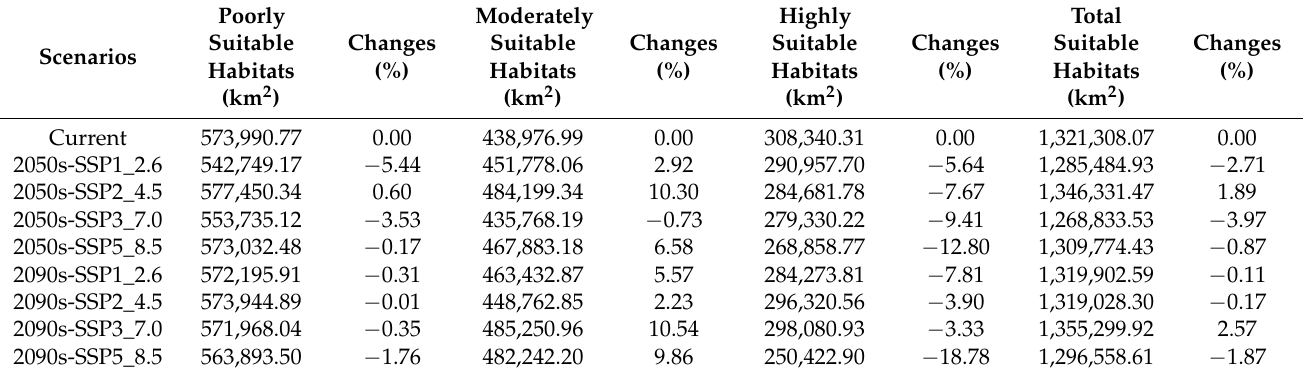
Table 4. Areas of suitable habitats for S. delavayi under future climate